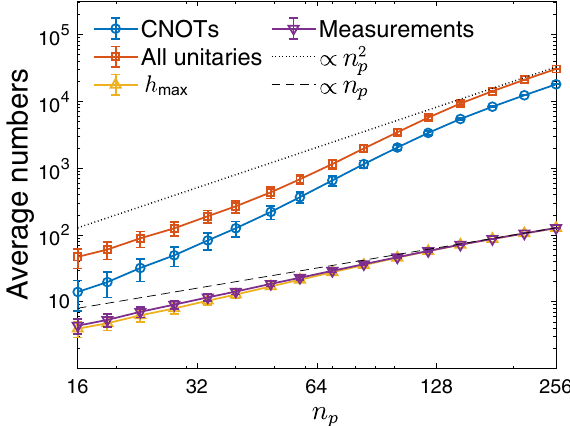
Fig. 3 Scaling of emitter number and generation circuit depth. The maximum value of the height function h max , measurement counts, and gate counts needed to produce random graphs of size n p are all averaged over 1024 graph realizations for each value of n p drawn from an Erdös – Rényi ensemble with edge probability p = 0.95. Dashed curves are included to show the scaling with n p and n 2 The error bars stand for the standard deviation of these